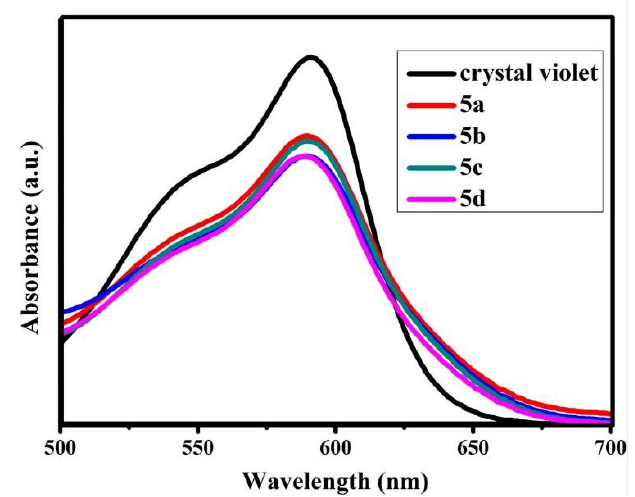
Figure 6. Crystal violet absorption spectra before and after addition of various B-L MILs in deionized water. Table 5. Summary of Brønsted acidity of B-L MILs ( A max : the maximum absorption, [I]: the concentration of indicator, [IH + ]: the concentration of protonated indicator, H o : Brønsted acidity). Compound